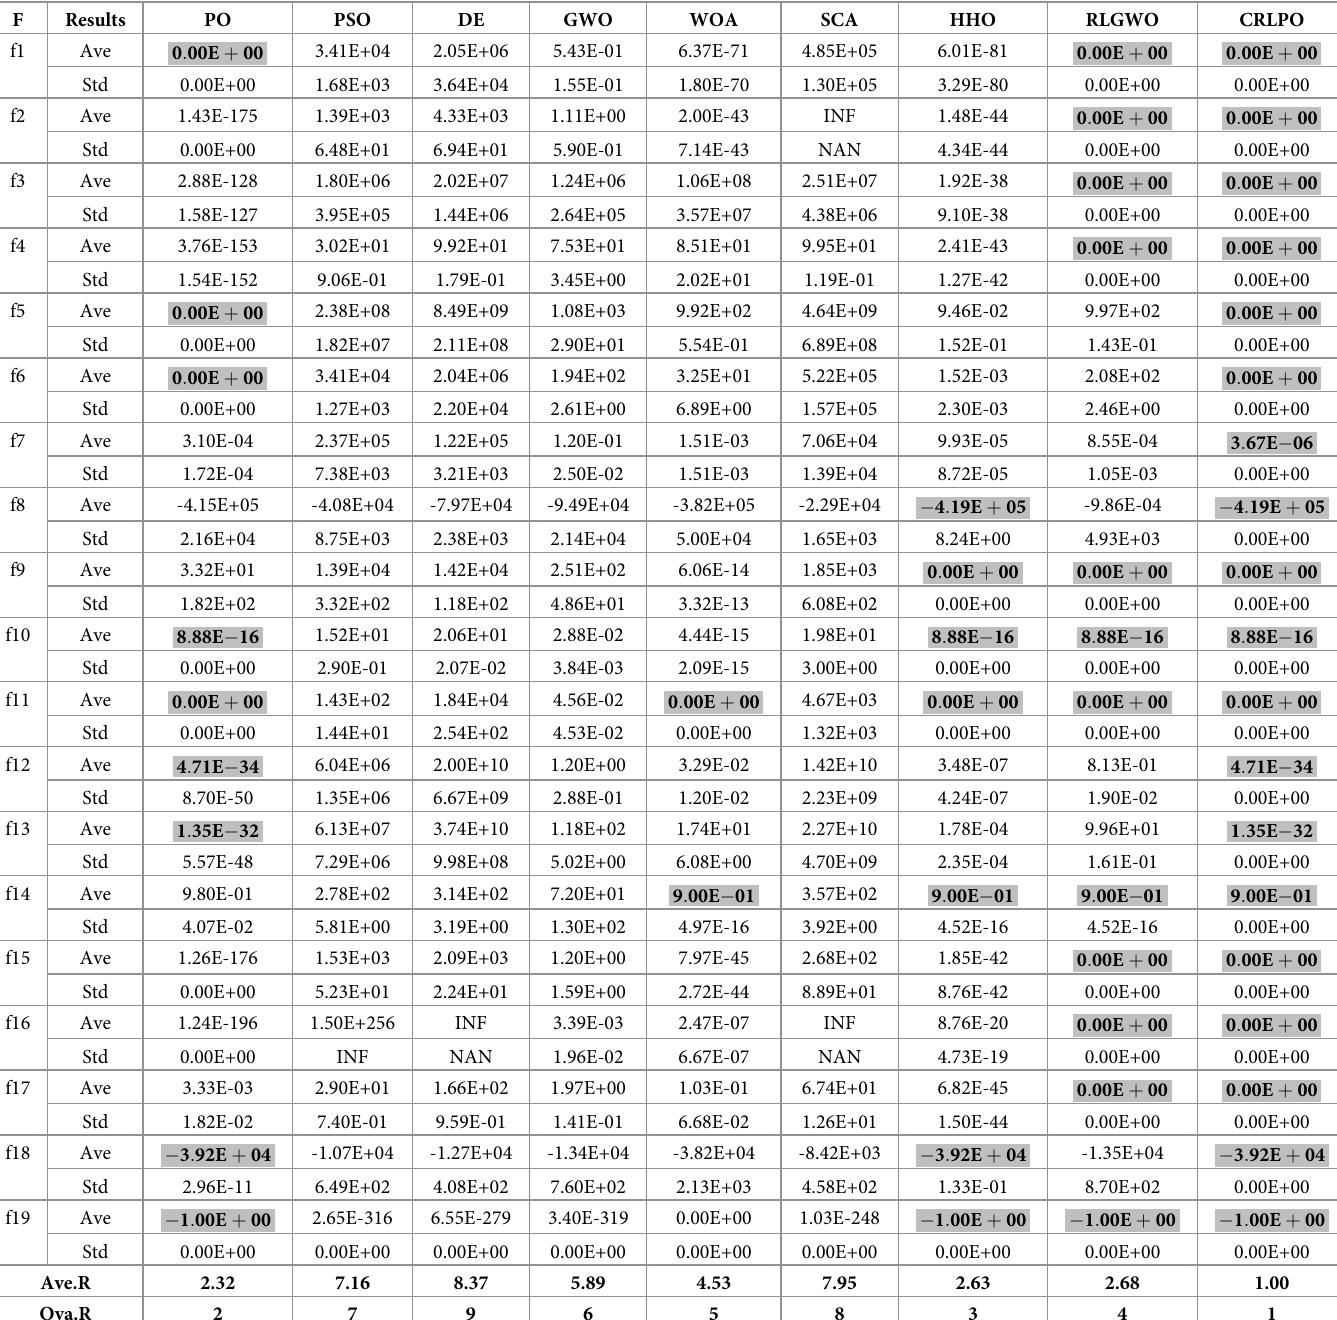
Table 6. Experimental results of 19 benchmark functions from Table 1 with 1000